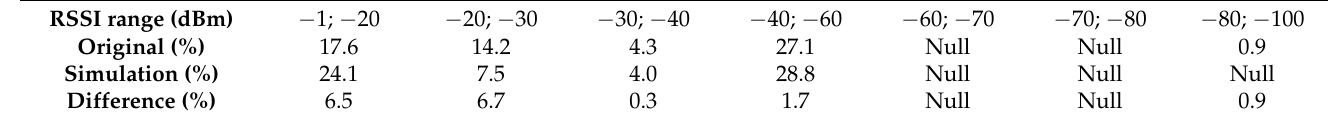
Table 4. Percentage of pixels in the heat map by RSSI ranges for antenna 1.